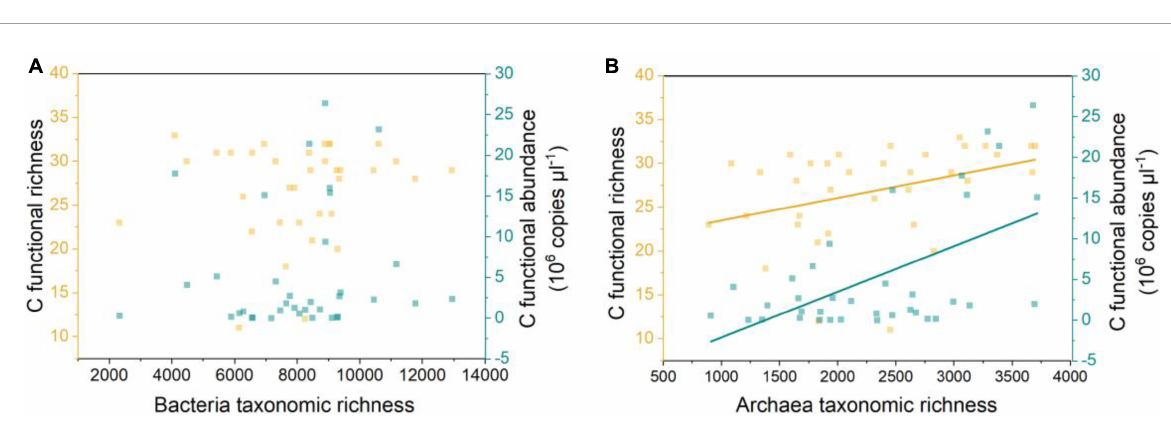
FIGURE4 Bacteria taxonomic richness vs. carbon-functional richness and carbon-functional gene absolute abundance (A) ; archaea taxonomic richness vs. carbon-functional richness and carbon-functional gene absolute abundance (B) ; the regression (yellow): y = 0.003 x + 20.91, adjust r 2 = 0.11, p < 0.05; the regression (green): y = 5.61 × 10 3 × –7.64 × 10 6 , adjust r 2 = 0.31, p <